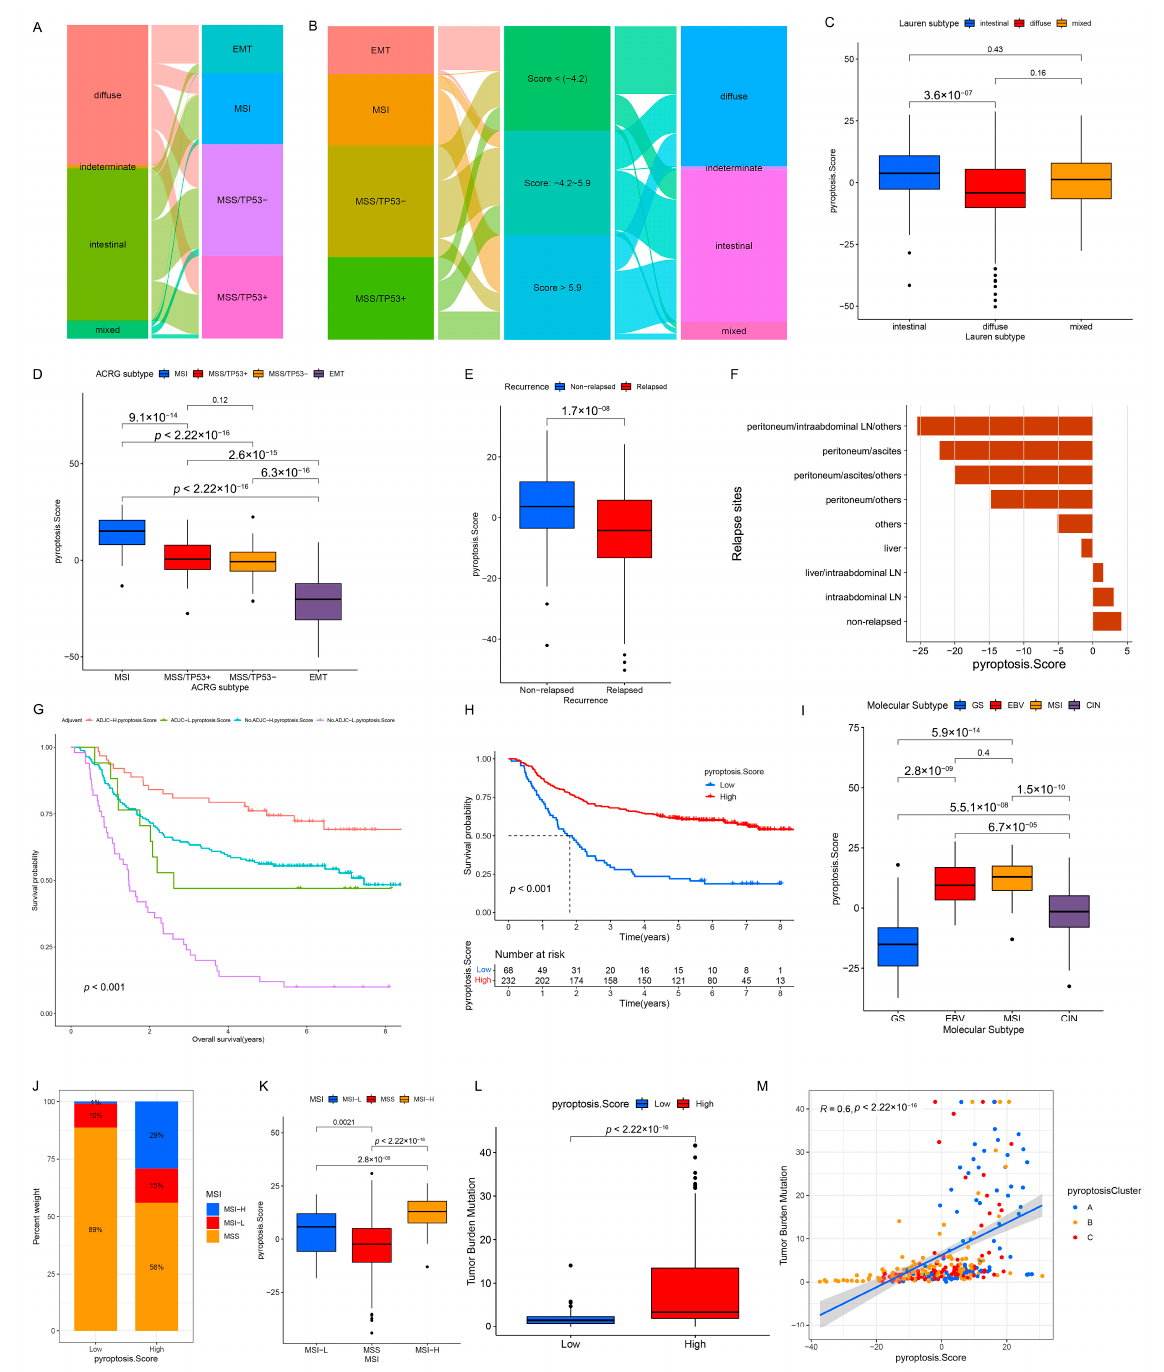
Figure 7. Correlation between the PS and existing GC subtypes and clinicopathologic traits. ( A ) Alluvial diagram of Lauren subtypes in groups with different ACRG subtypes in the GSE62254/ACRG cohort. ( B ) Alluvial diagram of the PS subgroups in groups with different ACRG subtypes and Lauren subtypes in the GSE62254/ACRG cohort. ( C – E ) Differences in the PS among Lauren subtypes ( C ), ACRG subtypes ( D ), and relapsed (or non-relapsed) subgroups ( E ) in the GSE62254/ACRG cohort (Kruskal–Wallis test). ( F ) The PS in different recurrent sites in the GSE62254/ACRG cohort. ( G ) Overall survival analysis for the subgroup patients stratified by both the PS and treatment with adjuvant chemotherapy using Kaplan–Meier curves. H, high; L, Low; ADJC, adjuvant chemotherapy (Log-rank test: p < 0.001). ( H ) Kaplan–Meier analysis for patients with high- and low-PS subgroups in the GSE62254/ACRG cohort (Log-rank test: p < 0.001). ( I ) Differences in the PS among the TCGA subtypes in the TCGA cohort. ( J ) The proportion of patients with different MSI statuses in the PS subgroups in the TCGA cohort. ( K ) Differences in the PS among the MSI statuses in the TCGA cohort. ( L ) Differences in the TMB among the low- and high-PS subgroups in the TCGA cohort. ( M ) Correlation analysis of the TMB and PS in the TCGA